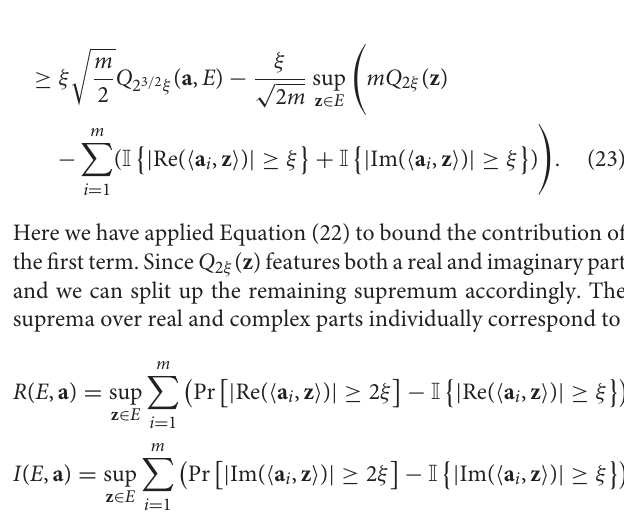
FIGURE 1 | ( Left ) Performance of basis pursuit for m counterpart (signed Bernoulli). ( Right ) Performance of basis pursuit for m sequences and their generic counterpart (standard complex Gaussian